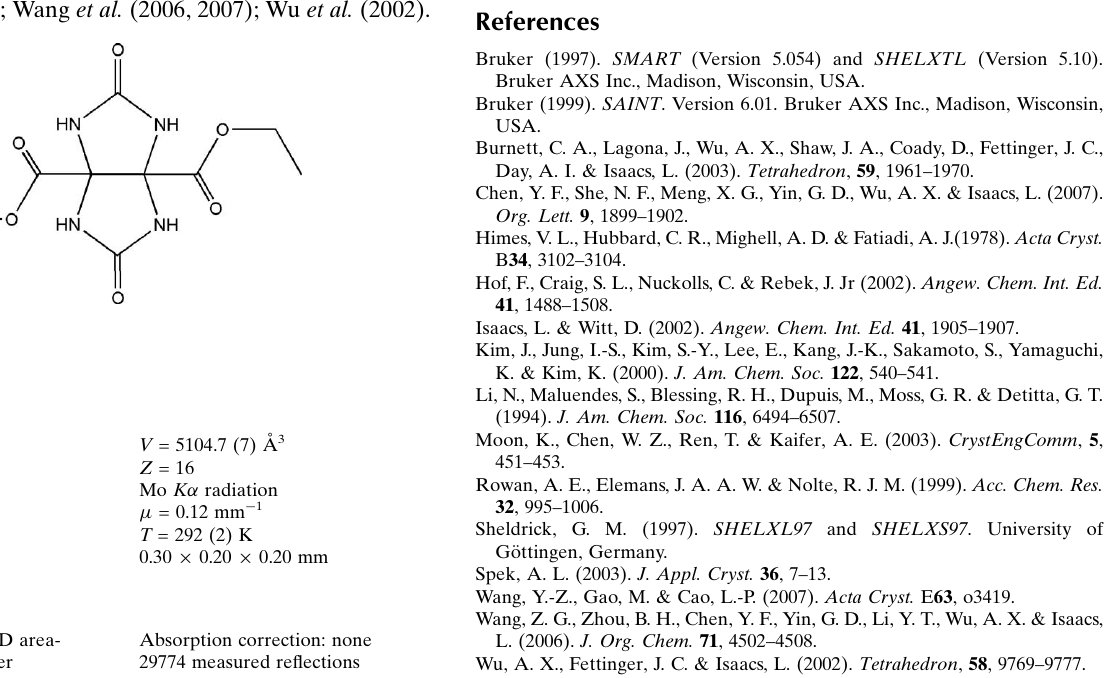
Absorption correction: none 29774 measured reflections